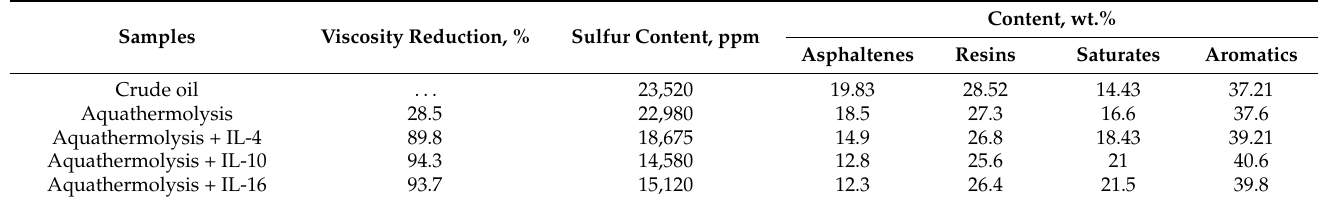
Table 4. Viscosity reduction, sulfur content, and SARA analysis of heavy crude oil before and after